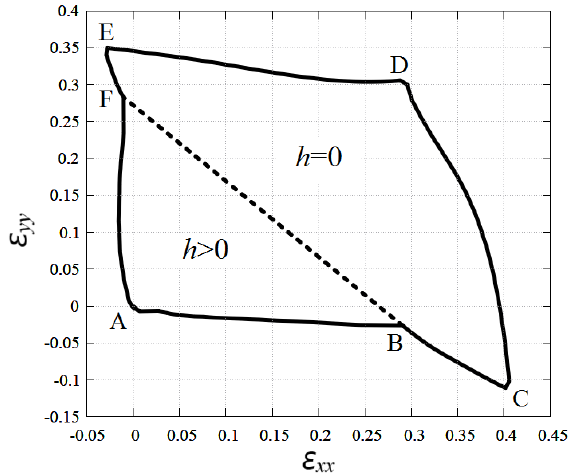
Figure 4. Stability region of planar stanene under normal strain components ε xx and ε yy at ε xy = 0. Inside the region ABCDEFA, planar stanene is stable. Dotted line separates the regions of buckled stanene ( h > 0) and absolutely flat stanene ( h = 0). The transition line is ε yy = − 1.03 ε xx + 0.272.